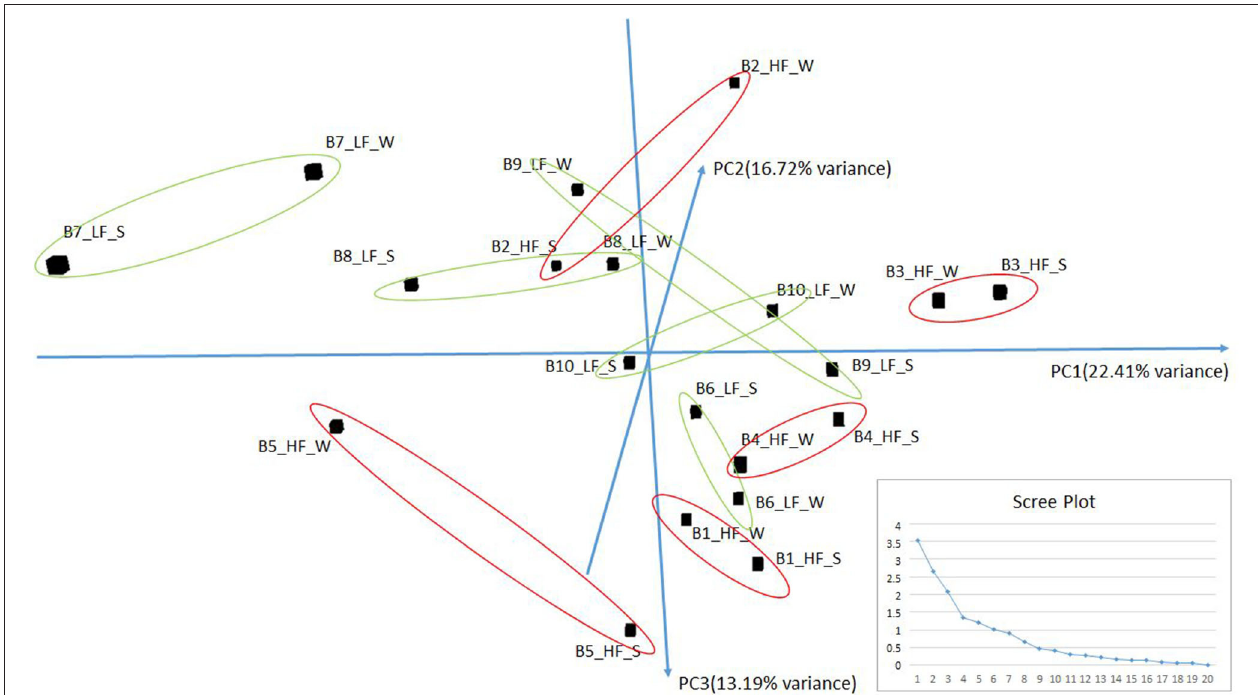
FIGURE 2 | PCA of the more abundant miRNAs ( n = 200) found in HF and LF bulls in the two seasons: Summer (S) and Winter (W). The scree plot, in the lower right corner of the figure, was reported to explore the optimal groups of the PCA ( x -axis: principal component, y -axis: eigenvalues).